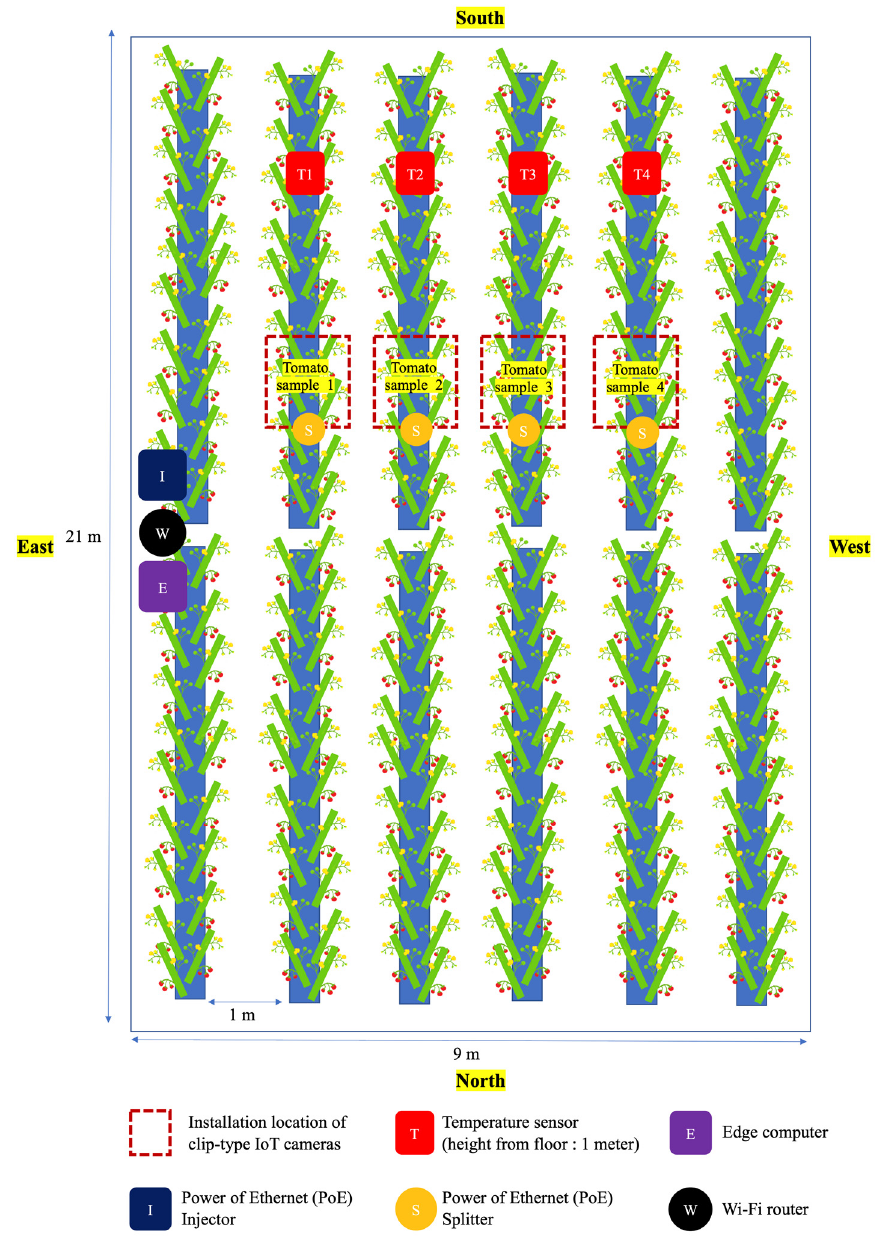
Figure 6. Layout of the experimental greenhouse.